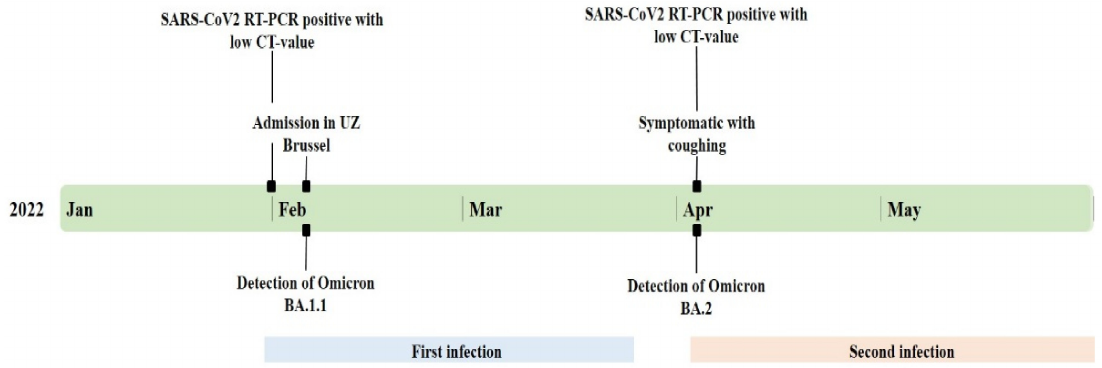
Figure 1. Timeline of patient’s hospitalization, including symptoms and genetic results; Ct: SARS- CoV-2 RT-qPCR cycle threshold.